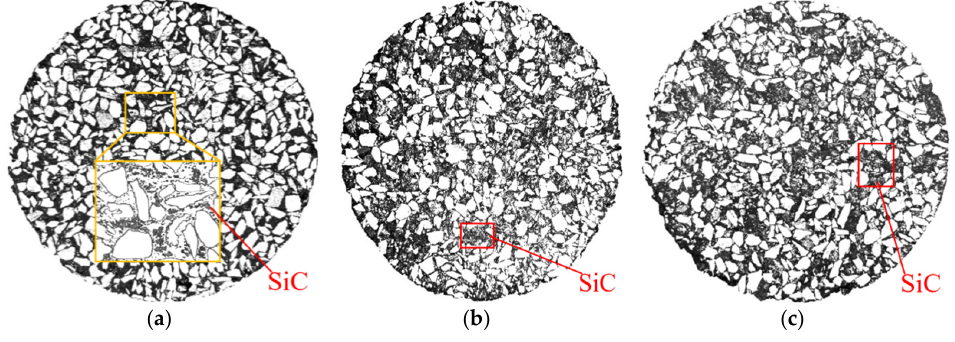
Figure 9. Distribution of SiC in ( a ) 1#; ( b ) 2#; ( c ) 3# specimens.